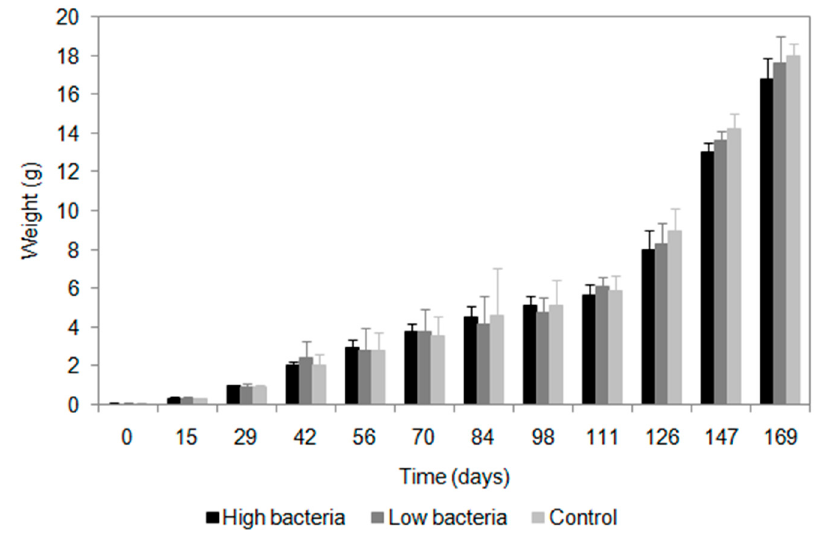
Figure 5. The shrimp weight gain. Each bar represents the average of the three experimental units for the high bacteria treatment (2.8 × 10 4 cfu / mL), low bacteria treatment (2.8 × 10 3 cfu / mL) and control treatment.